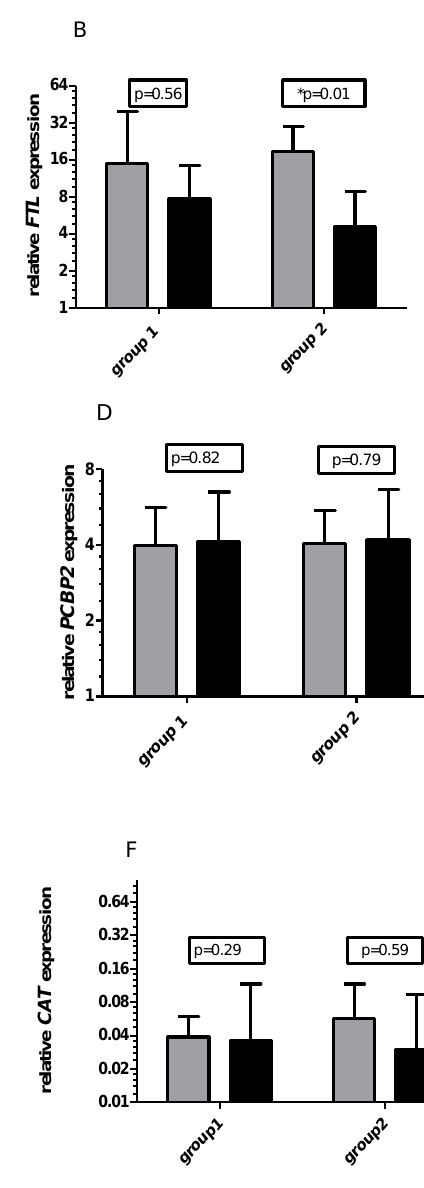
Figure 1. Changes in relative expression (2ˆ) of ferritin heavy chain ( FTH ) ( A ), ferritin light chain ( FTL ) ( B ), poly(rC)-binding protein 1 ( PCBP1 ) ( C ), poly(rC)-binding protein 2 ( PCBP2 ) ( D ), forkhead box O3A (FOXO3a ) ( E ), and catalase ( CAT ) ( F ) before (grey bars) and after 6 weeks (dark bars) training period supported by Vitamin C supplementation. All mRNA expressed as 2ˆ relative expression / TUBB. * significant differences within the group, compared to the baseline value.